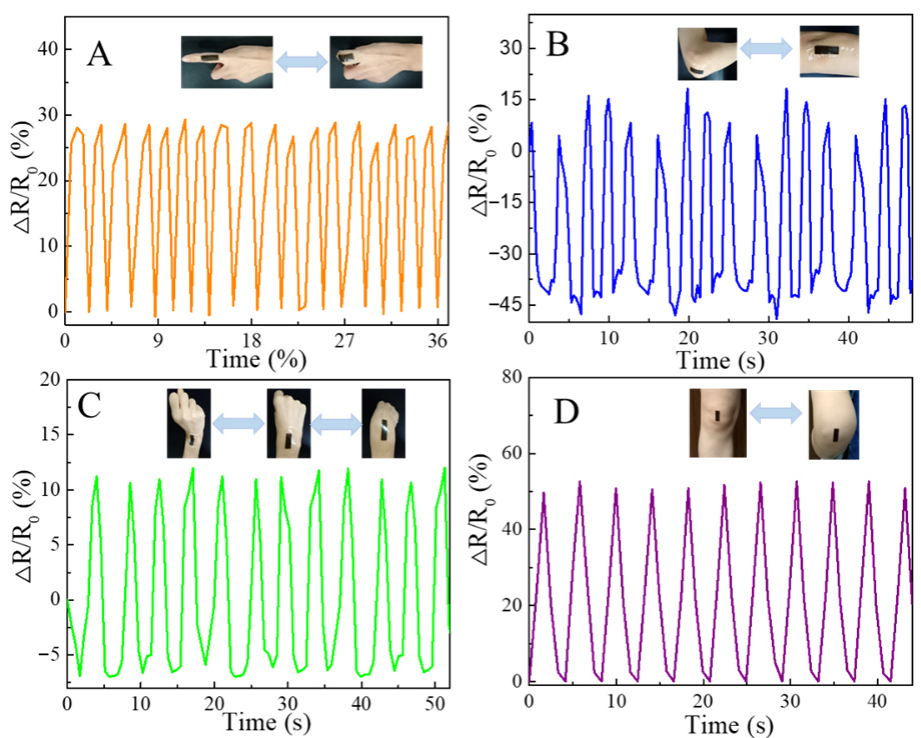
Figure 8. Relative resistance change ( Δ R / R 0 ) of PTAA-5 hydrogels on the surfaces of skin covering various joints, including: ( A ) a finger, ( B ) an elbow, ( C ) a wrist, and ( D ) a knee.